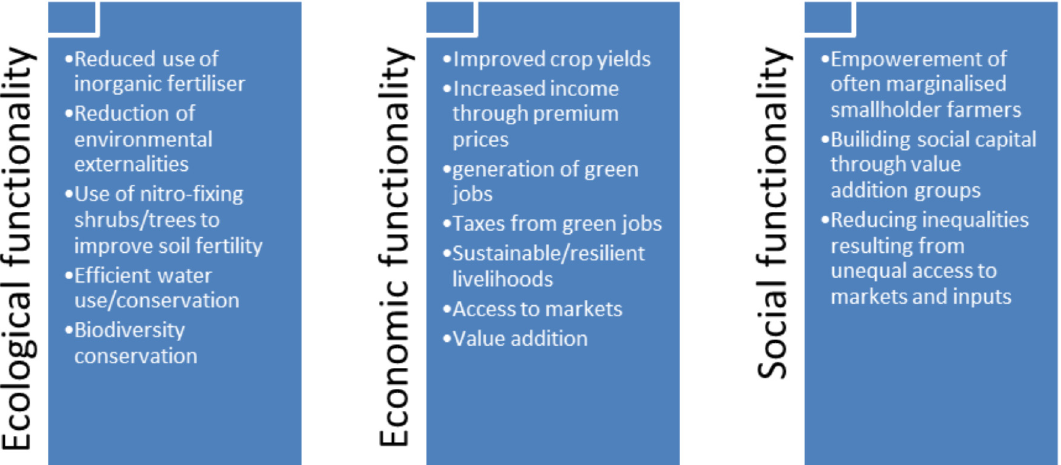
Figure 7. Multifunctionality of the COMACO agricultural model.